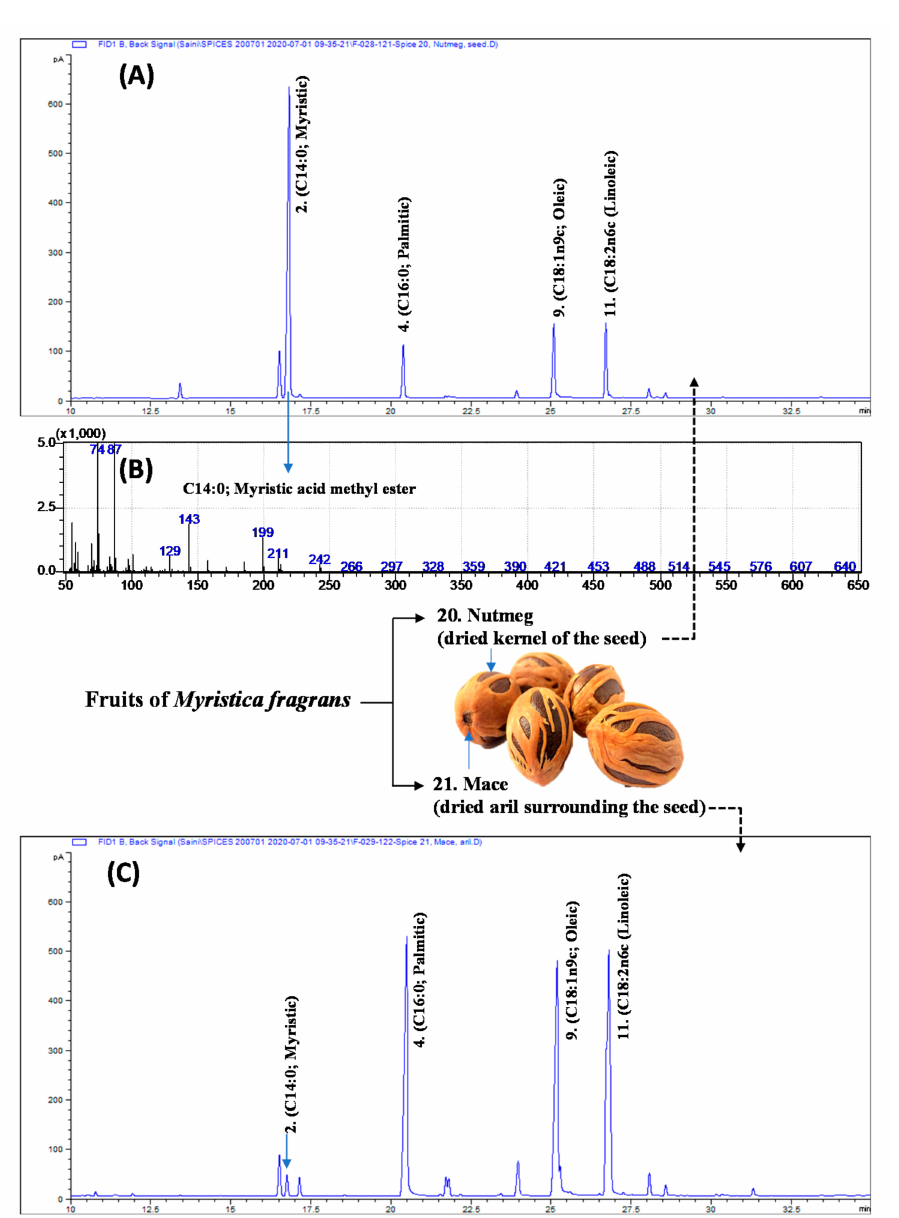
Figure 1. ( A ) The gas chromatography (GC)-flame ionization detection (FID) profiles of fatty acid methyl esters (FAMEs) of nutmeg. ( B ) The GC-mass spectrum of dominating fatty acid (myristic acid) from nutmeg. ( C ) The GC-FID profiles of FAMEs of mace. The numbers, 2, 4, 6, and 8 correspond to peak numbers illustrated in Table